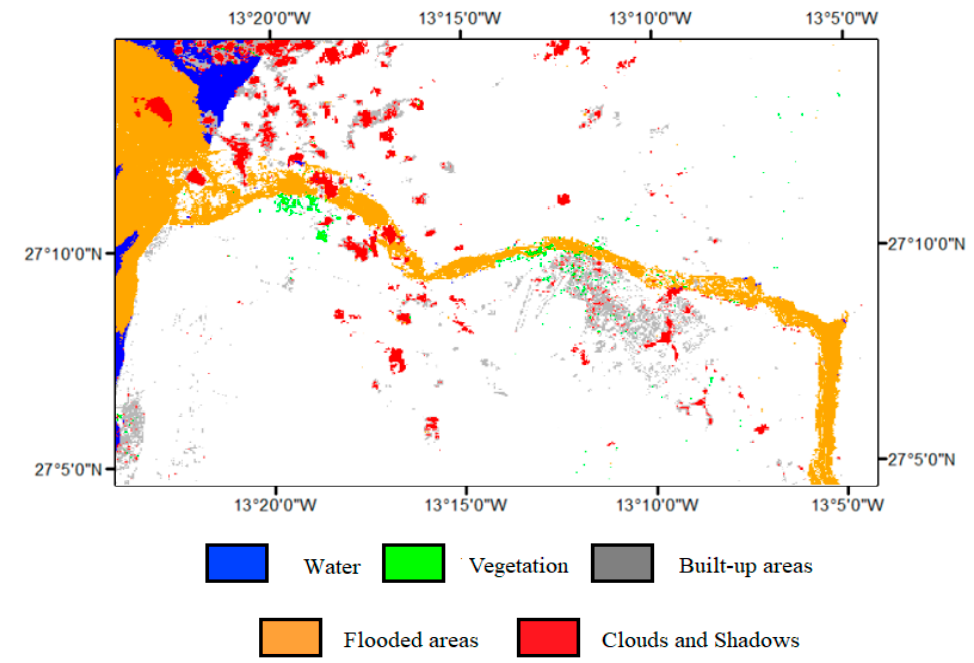
Figure 16. SVM classifier’s results for the date after the event (30 October 2016). The overall accuracy and kappa coefficient are 87.31% and 0.82, respectively. The presence of clay in flooded water helped to distinguish the flooded areas, and the reflec- tance in the visible range and specifically the blue, red, and green spectra were enough to detect it. The added NDVI band separated the vegetation from the other classes and made the decision rule easy for the classifier. This map shows the impact that the flash flood had on the area; the overflow surpassed the dam and affected some neighboring buildings and half of the farmed zone before discharging into the Atlantic Ocean at the outlet called Foum El Oued. For change detection, we used the decision tree classifier as a post-classification change detection tool (Figure 17). It has rarely been used in the literature for this purpose.